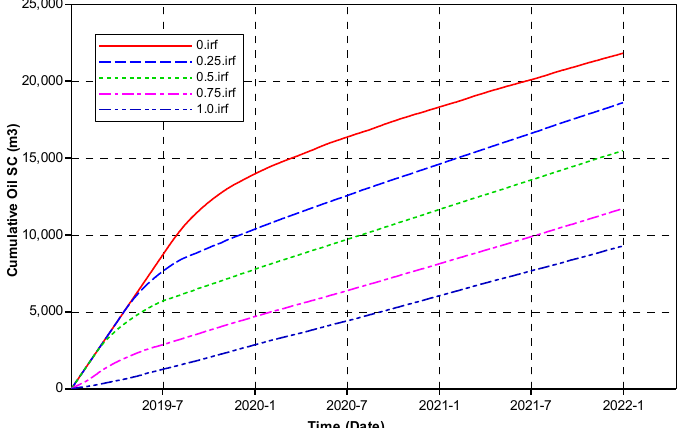
( b ) Figure 6. Mass fraction distribution of components of oil after steam flooding. ( a ) Mass fraction distribution of heavy components. ( b ) Mass fraction distribution of light components. 3.3. Results and Analysis 3.3.1. Different Ratios of Light and Heavy Components In the geological model, the light and heavy components were proportioned with different mass fractions to make the heavy components accounted for 0%, 25%, 50%, 75% and 100% of the crude oil mass fraction. Then, the effects of different ratios on the quantity of remaining oil and the retention of different components after steam flooding were an-